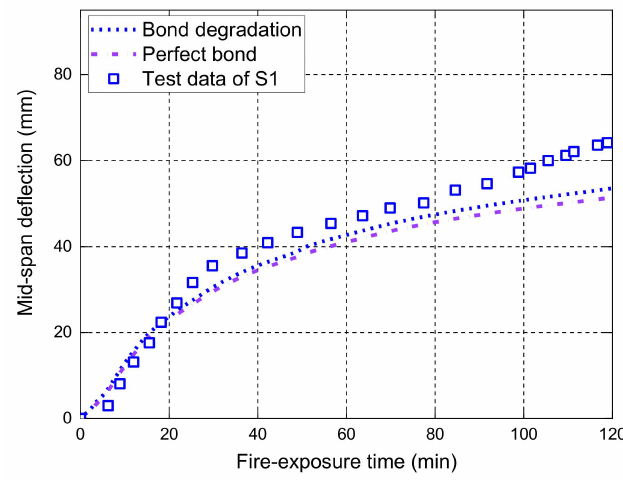
Figure 11. Effect of bond degradation on the midspan deflection responses of S1.